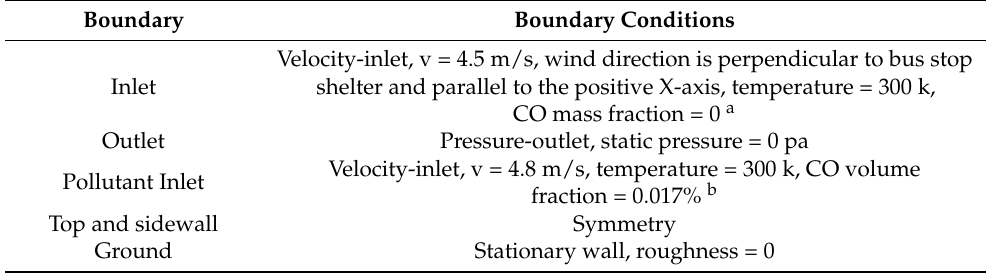
Table 5. Boundary condition of the physical